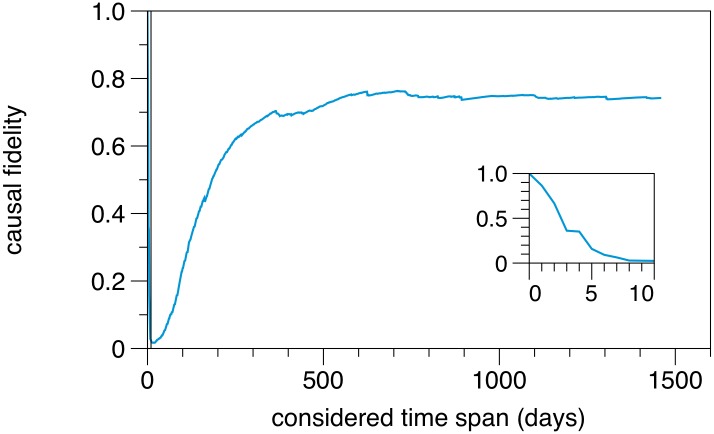
Causal fidelity for different aggregation windows.For aggregation windows < 365 days, the static network representation should be used with caution. A static network view is also adequate for very short aggregation windows (inset). The static network considered in this work corresponds to the rightmost datapoint, i.e. the maximum possible aggregation window.